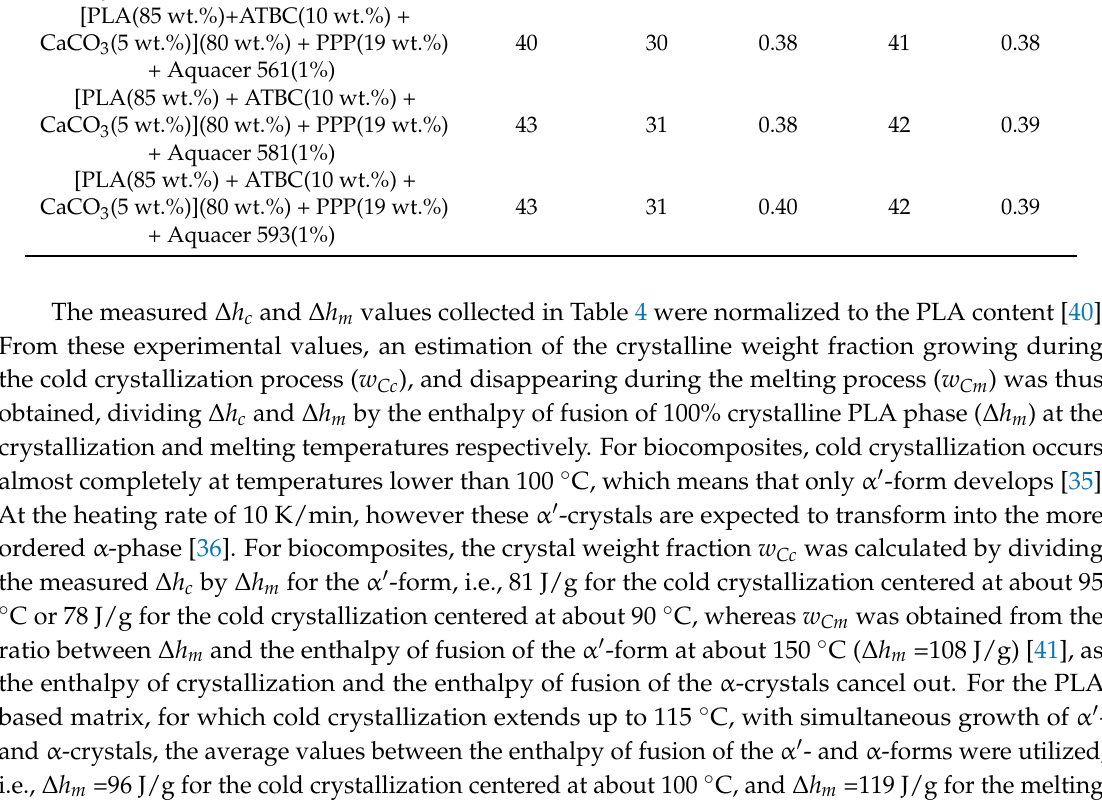
Table 4. Glass transition temperatures ( T g ), enthalpy of cold crystallization ( ∆ h c ), enthalpy of melting ( ∆ h m ), and crystalline weight fraction growing during cold crystallization ( w Cc ) and disappearing during melting ( w Cm ) for the as prepared PLA based matrix and biocomposites. (estimated errors: ± 0.5 ◦ C for T g ; ± 1 J/g for ∆ h c and ∆ h m , and ± 0.02 for w Cc and w Cm ). Formulation T g ( ◦ C) ∆ h c (J/g) w Cc ∆ h m (J/g) [PLA(85 wt.%) + ATBC(10 wt.%) +